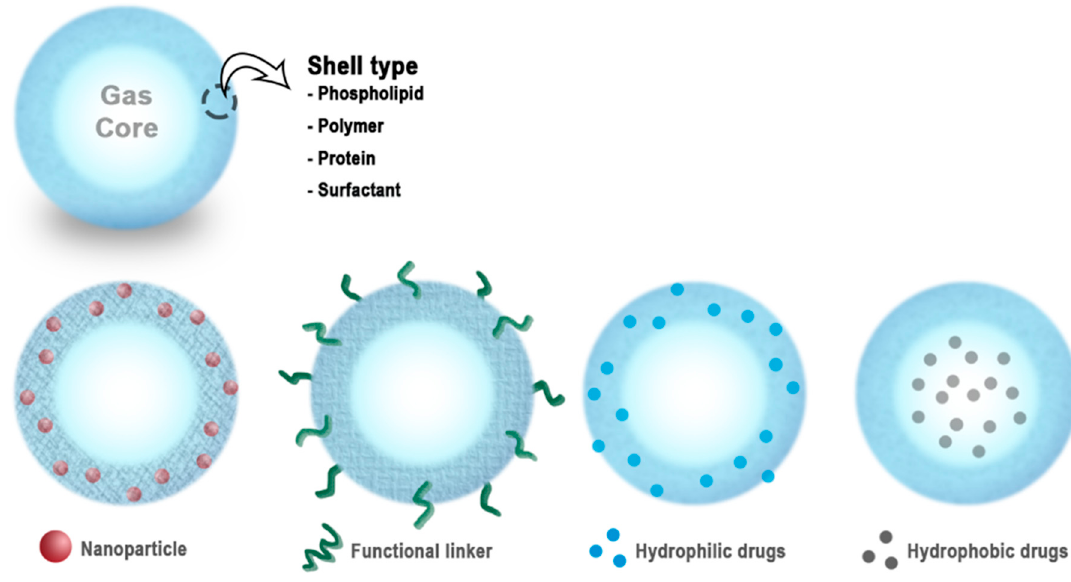
Figure 1. Schematic of micro/nanobubbles (MNBs), and their functionalization. This figure has been adapted from various studies [22,47,49,55,56].